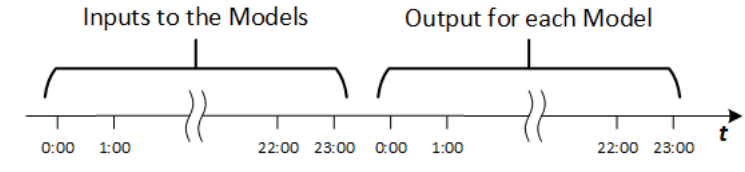
Figure 4. Input and output variables in time distribution.